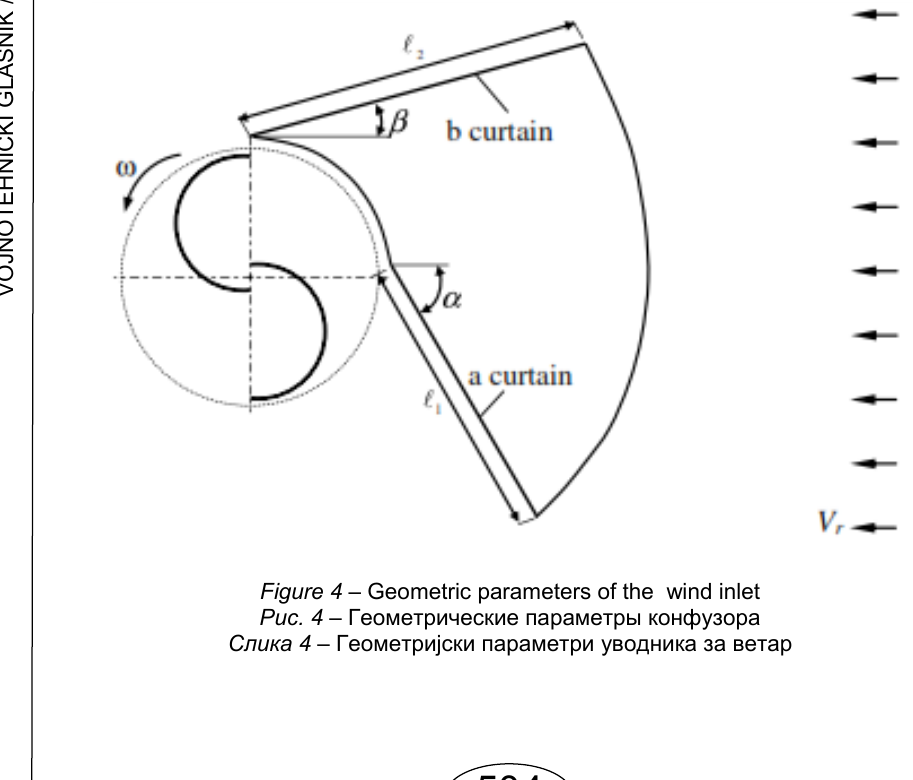
Figure 4 – Geometric parameters of the wind inlet Рис . 4 – Геометрические параметры конфузора Слика 4 – Геометријски параметри уводника за